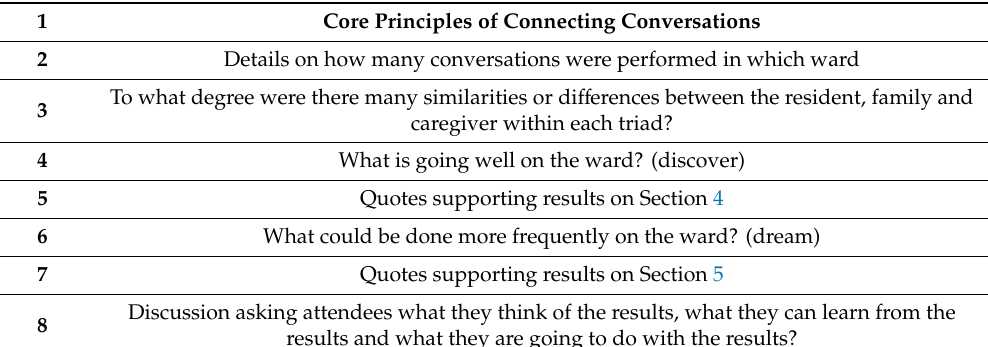
Table A3. Outline of